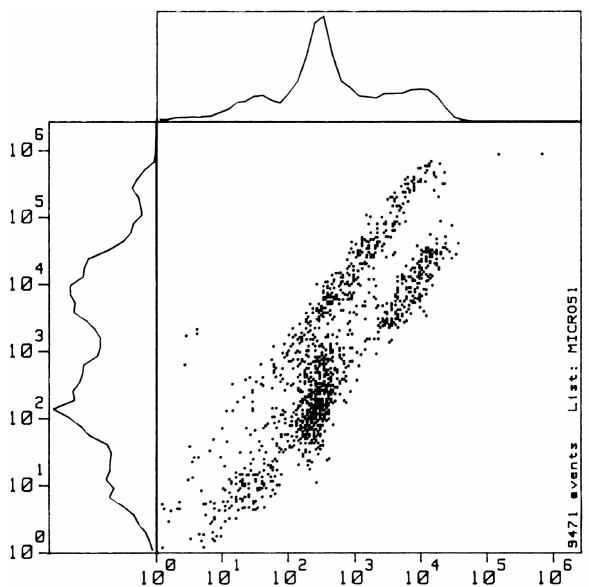
IG . 2. – An example of a bivariate scatter plot, with corresponding univariate frequency distributions, of a fresh water field sample containing single cells and some colony forming cyanobacterial species, measured with an OPA flow cytometer. Vertical axis = side scatter; horizontal axis = forward scatter. Each dot in the scatter plot represents an individual particle. The frequency distributions show the number of particles versus their measured forward or side scat- ter value (horizontal and vertical distribution respectively, numbers normalized to fit the